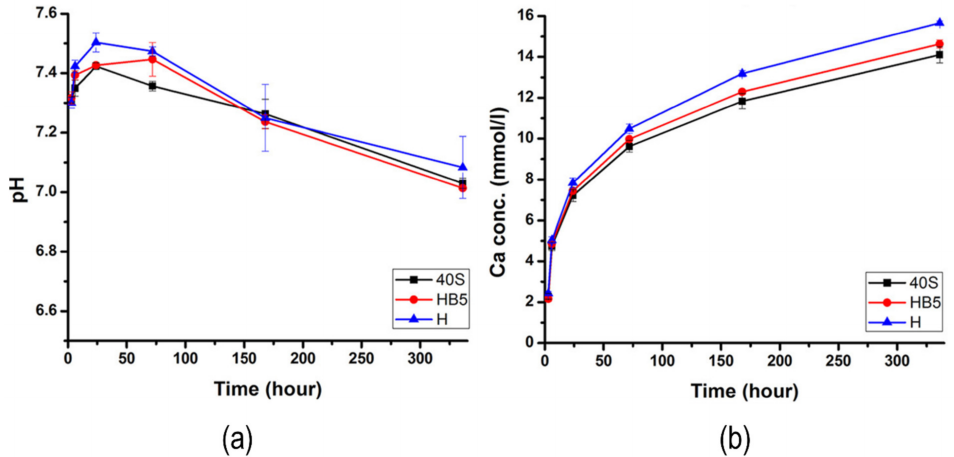
Figure 7. ( a ) pH change ( b ) Ca ion concentration in SBF solution for different compositions of BG coatings on stainless steel. Reprinted with permission from